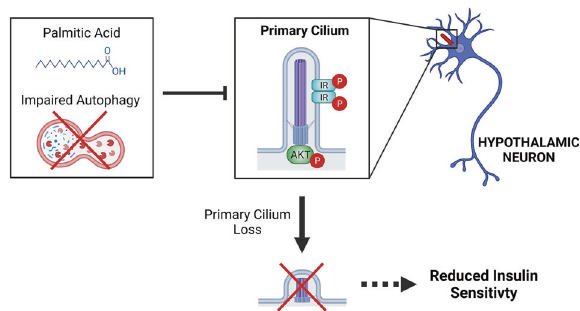
Fig. 6 Primary cilium loss induced by palmitic acid or autophagy impairment reduces insulin sensitivity. Our results indicate that conditions which impair autophagy, such as PA exposure or chemical and genetic inhibition of autophagy, obtained by treatment with the autophagy inhibitor Ba fi lomycin A1 or Chlor- oquine or downregulation of essential autophagy genes, causes cilia loss in hypothalamic neuronal cells. We also show that proteins required for insulin signaling (IR and AKT) localize at the primary cilium, promoting insulin sensitivity. Consistently, conditions that cause cilia loss impair insulin signaling in hypothalamic neurons. p- IR: phosphorylated insulin receptor; p-AKT: phosphorylated protein kinase B (also known as AKT). Figure created with